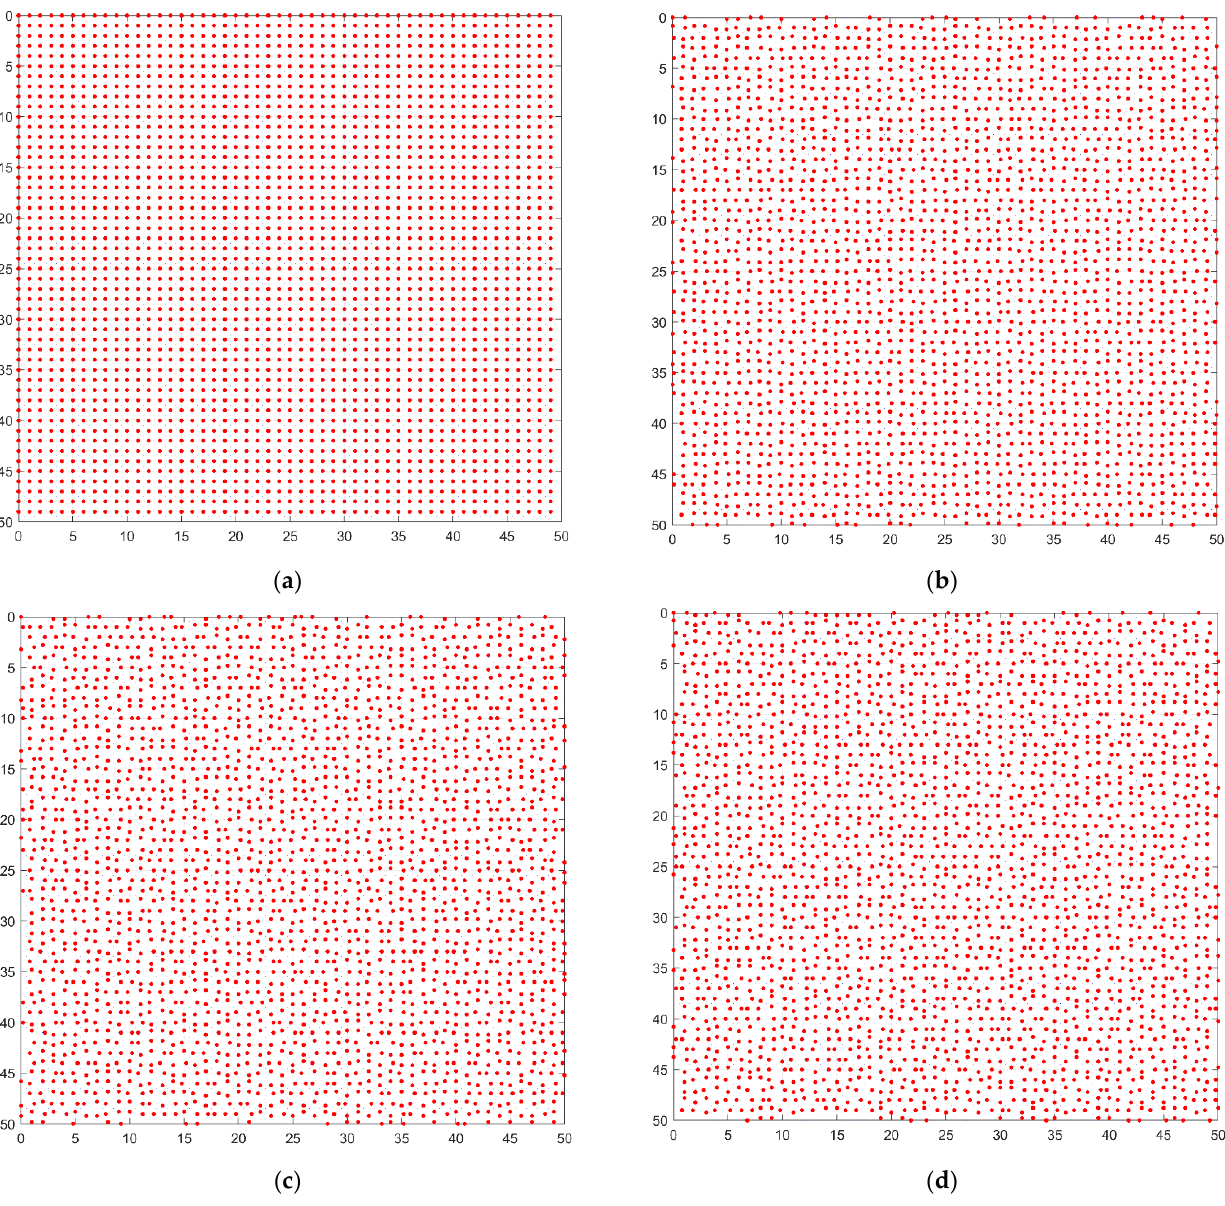
Figure 8. The arrangement of film atoms for elasticity modulus equal to substrate amplitude ( 𝑔/𝐴 = 1 ) and different values of parameter 𝐵 : ( a ) 𝐵 = 0.1 , ( b ) 𝐵 = 0.5 , ( c ) 𝐵 = 1.0 , ( d ) 𝐵 = 2 . Increasing the parameter 𝐵 disrupts the arrangement of the film atoms. Atoms are located in the nodes of the square lattice at small values of parameter 𝐵 . This state corre- sponds to the crystalline phase. The displacement of atoms occurs when the parameter 𝐵 increases. The film enters the amorphous phase. The far order is absent in this phase, but the near order is present. The change in the atom ’ s location is caused by the change of a substrate potential landscape. Substrate potential surfaces for different values of parame- ter 𝐵 are shown in Figure 9.